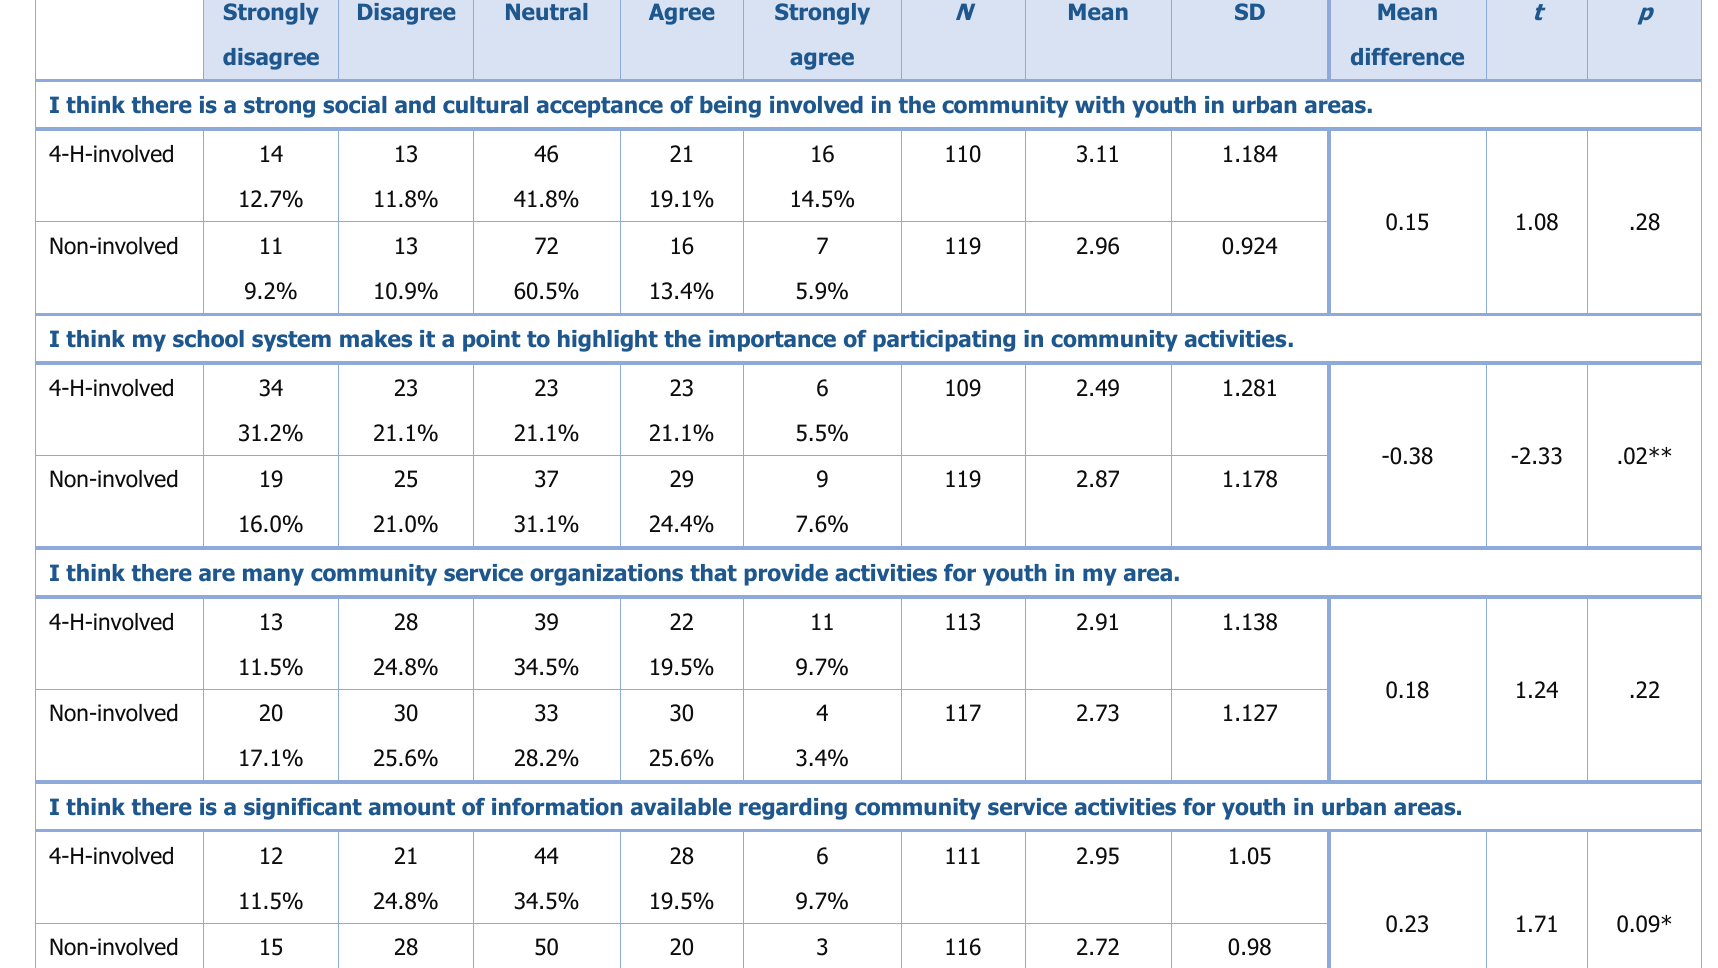
Table 4. Questionnaire Response Summary: Knowledge and Attitudes Toward Community Involvement Strongly Disagree Neutral Agree Strongly disagree